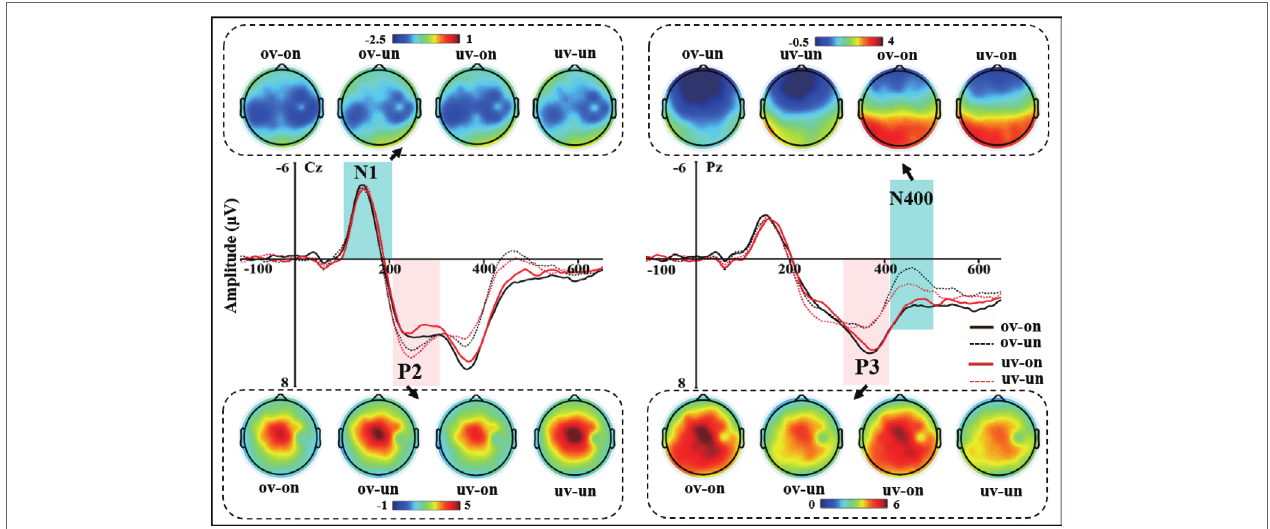
FIGURE 2 | The grand-averaged ERP waveforms at Cz and Pz and the topographic maps of N1, P2, P3, and N400 for four experimental conditions. The light blue bar of left panel highlighted the time-window of the N1 (110–210 ms), no any significant differences were found. The light pink bar of left panel highlighted the time-window of the P2 (210–310 ms). Difference in P2 mean amplitudes between psychological-self and non-psychological-self are shown in the left panel. The light pink bar of right panel highlighted the time-window of the P3 (310–410 ms), difference in P3 mean amplitudes between psychological- and non-psychological-self are also shown in right panel. The light blue bar of right panel highlighted the time-window of the N400 (420–480 ms). Difference in N400 means amplitudes between physical- and non-physical-self are also shown in right